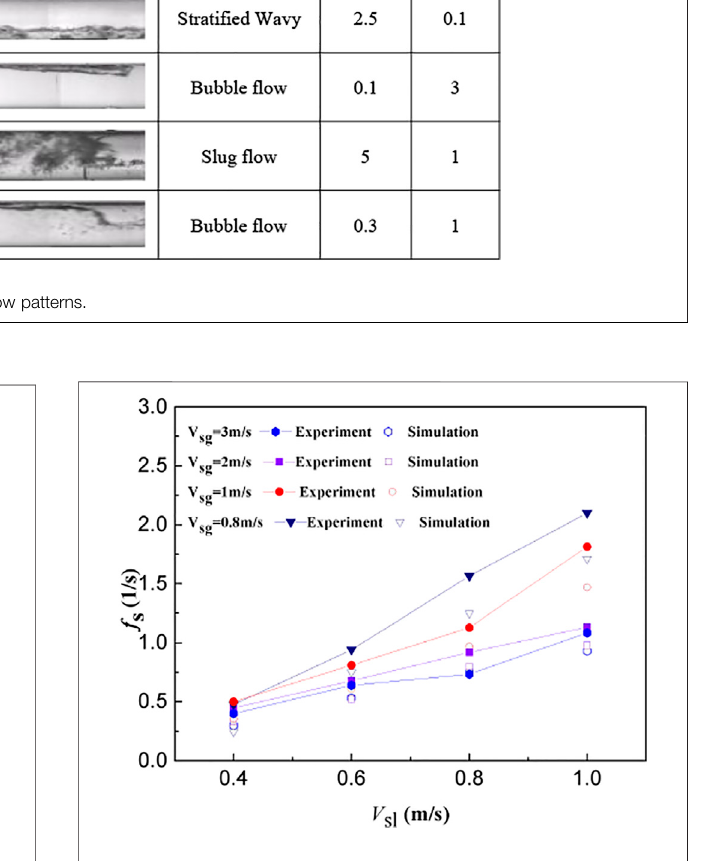
FIGURE 9 | Comparison between simulation value and experimental value of slug frequency (L/D (cid:2)